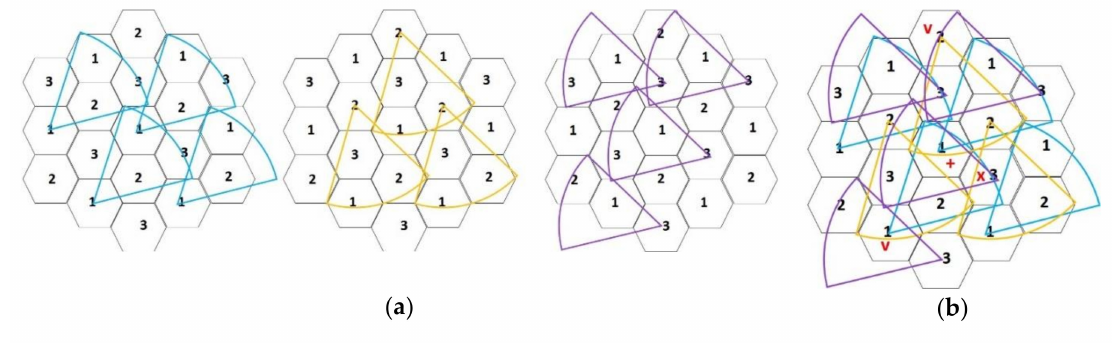
Figure 5. ( a ) Directions of transmissions for sensors located in di ff erent groups during the first mini-slot; ( b ) concurrence of transmissions among sensors during the first